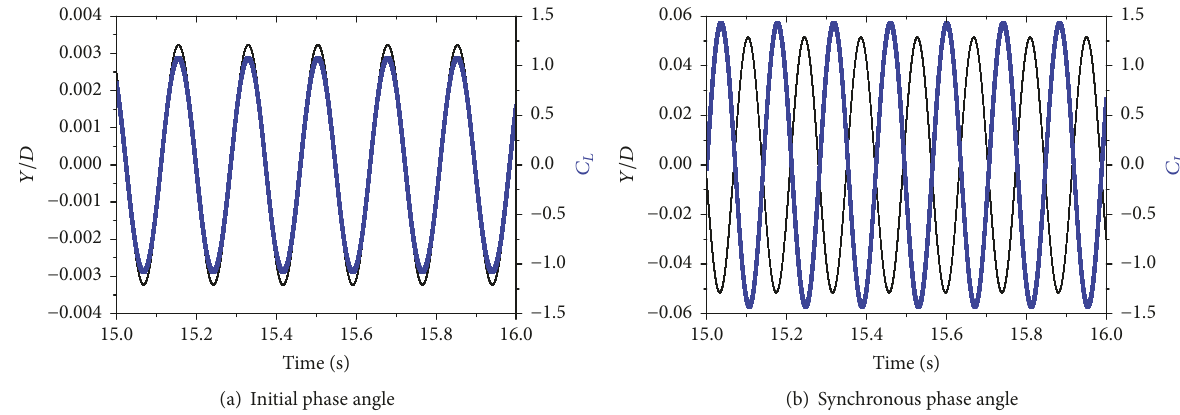
Figure 12: Results of phase angle in initial and synchronization state for 𝛼 = 0 ∘ .